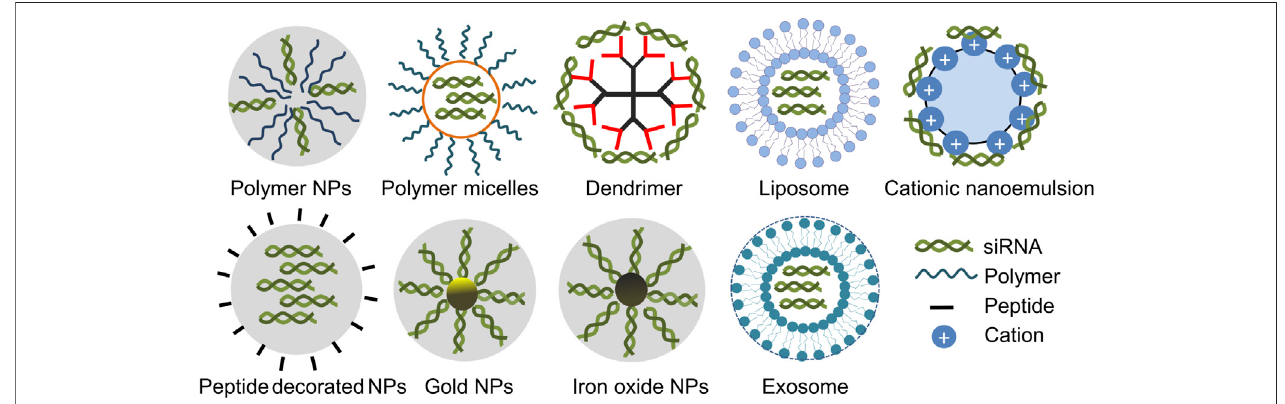
FIGURE2 | Simpli fi ed diagrams ofsome representative carriers applied forsiRNA delivery in gliomas. siRNA carriers including polymer NPs(Karlsson et al., 2021), polymermicelles(Zhangetal., 2020a),dendrimer (Qiuet al.,2018),liposome (Hu etal.,2021),nanoemulsion (Teixeiraet al.,2020),peptide decorated NPs(Zhenget al., 2019), gold NPs (Kumthekar et al., 2021), iron oxide NPs (Kievit et al., 2017) and exosome (Fu et al., 2021).